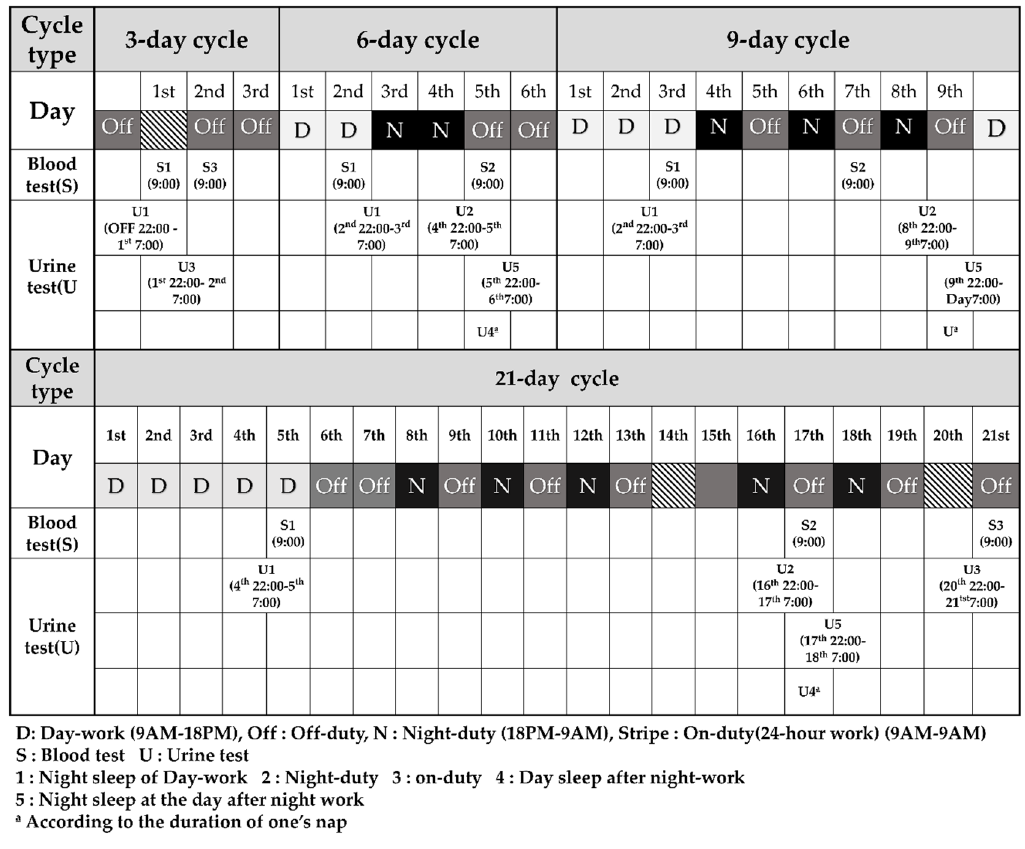
Figure 1. The work schedule by shift cycle.